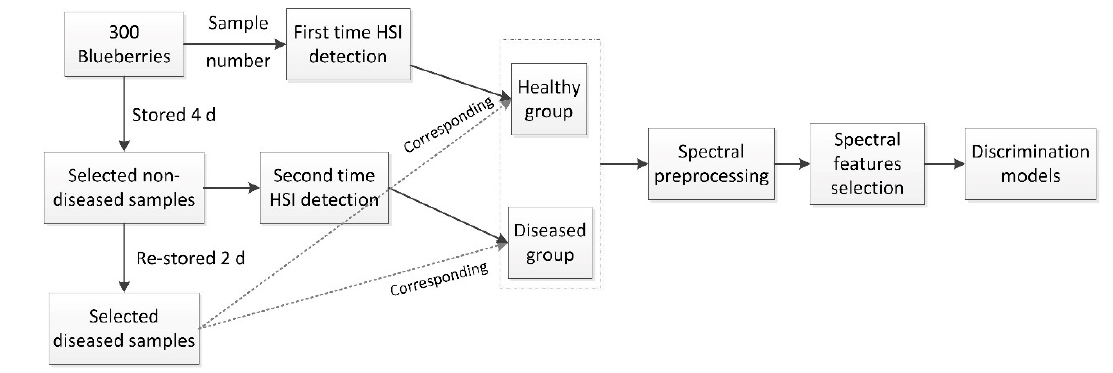
Figure 1. Flowchart of analytical procedure for disease detection.